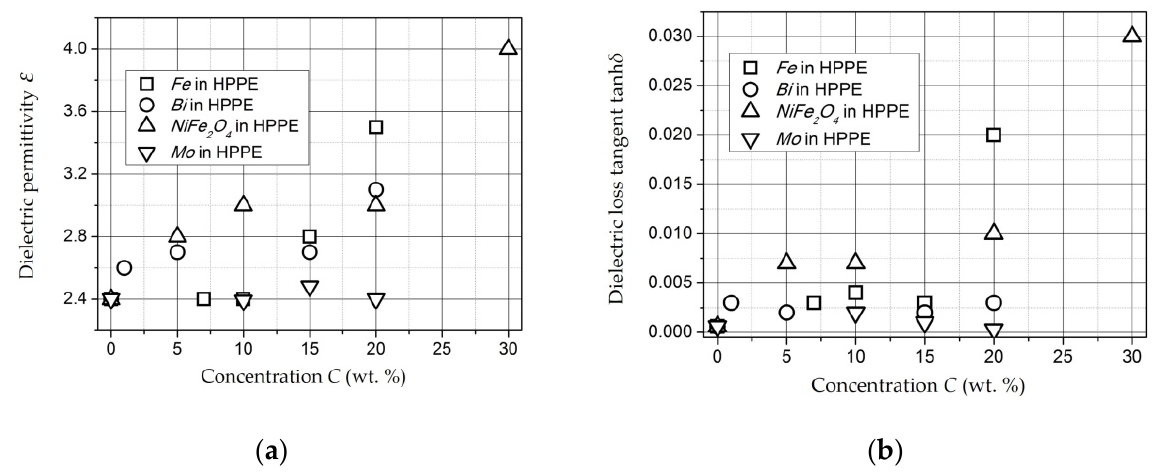
Figure 19. Dependence of dielectric permittivity ( a ) and dielectric losses ( b ) of nanocomposites on concentration of the nanoparticles Fe , Bi , NiFe 2 O 4 , and Mo .